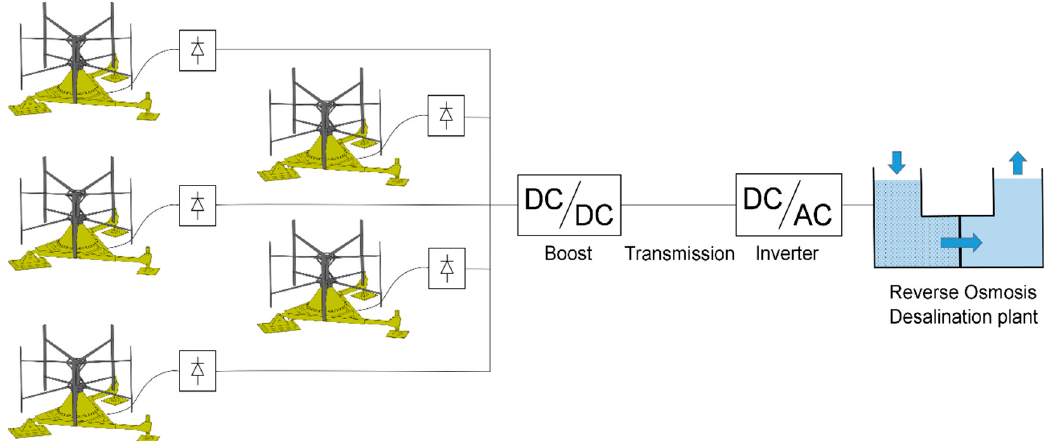
Figure 5. Rough overview of the proposed MCC, with the exception that the final proposed system includes 10 MCCs and water storage, powered desalination system.